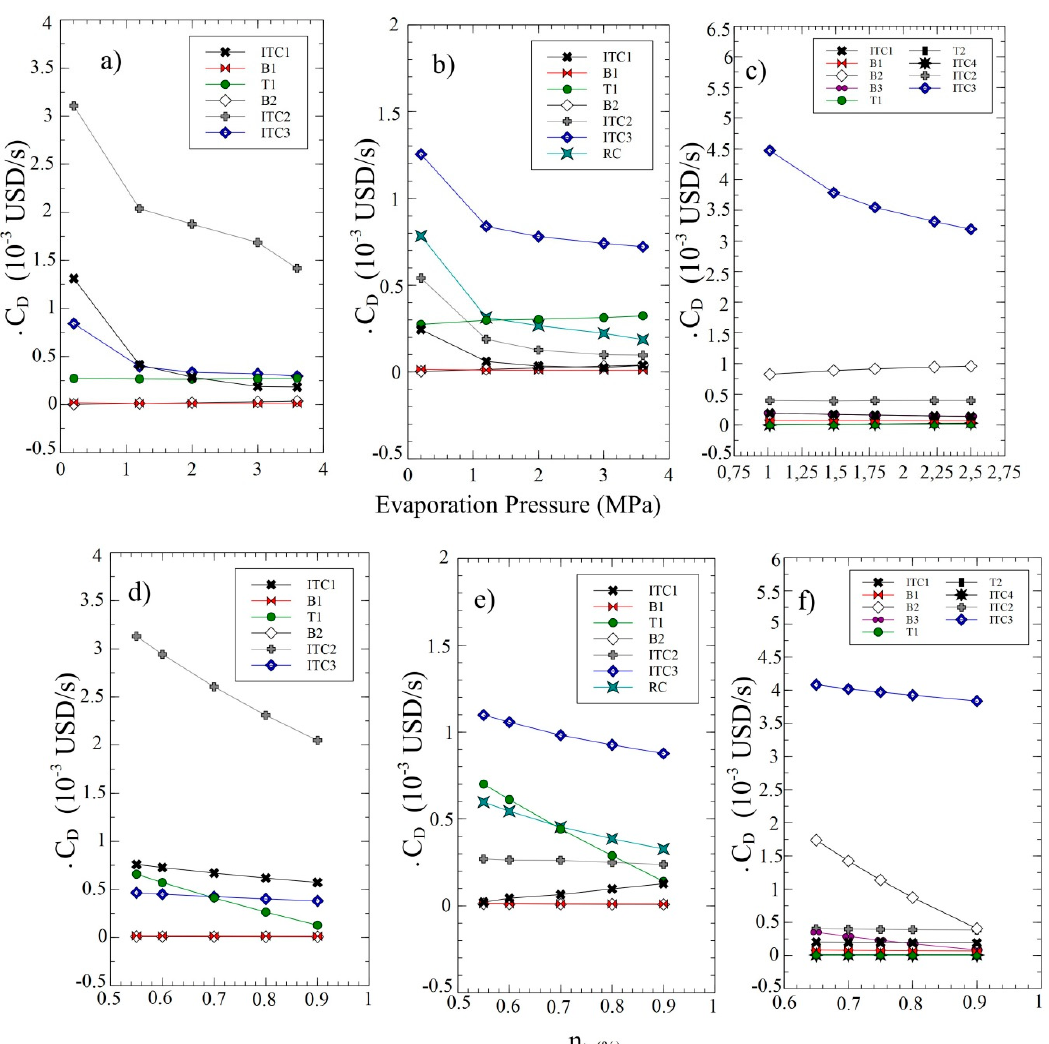
Figure 4. E ff ect of evaporating pressure and turbine e ffi ciency on the cost rate of exergy destruction by Figure 4. Effect of evaporating pressure and turbine efficiency on the cost rate of exergy destruction component, ( a – d ) SORC, ( b – e ) RORC, and ( c – f ) by component, ( a – d ) SORC, ( b – e ) RORC, and ( c – f ) DORC.